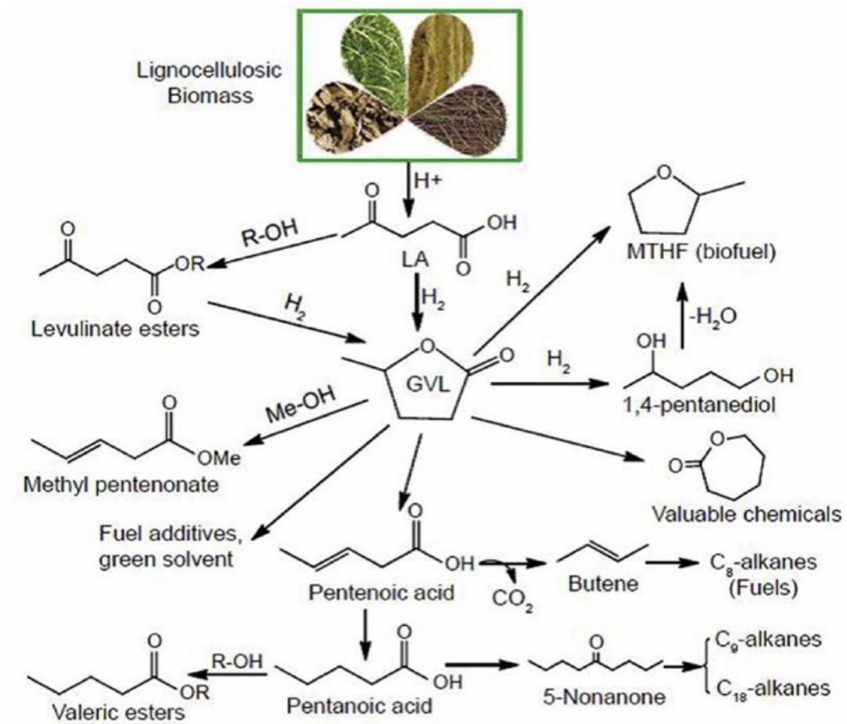
Figure 3. Schematic illustration of different important products that can be derived from GVL. Reproduced from ref [35] with permission from